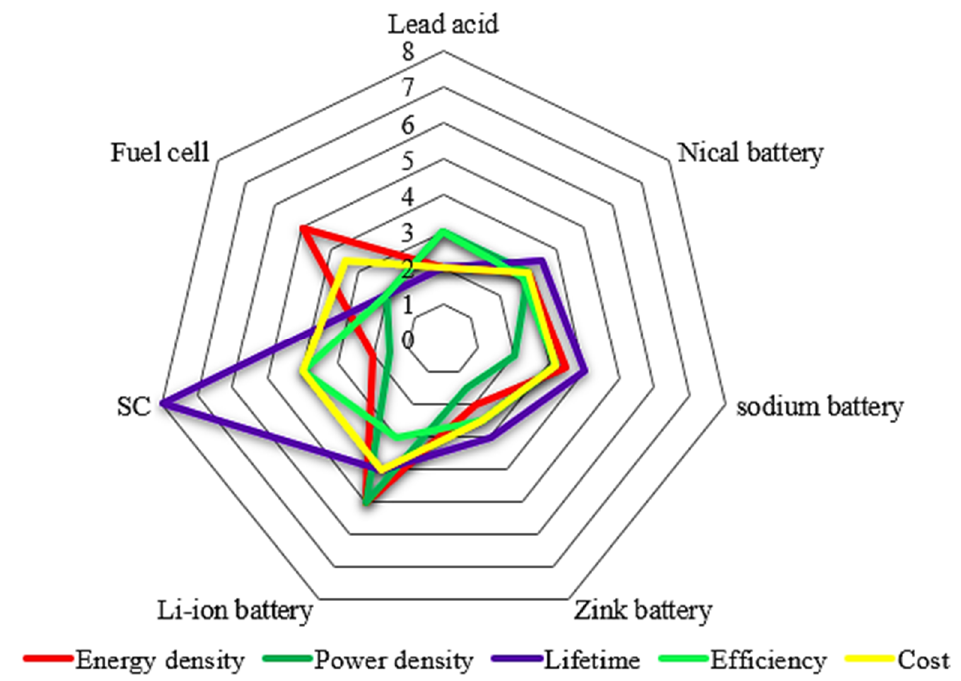
Figure 6. Comparison between different ESSs